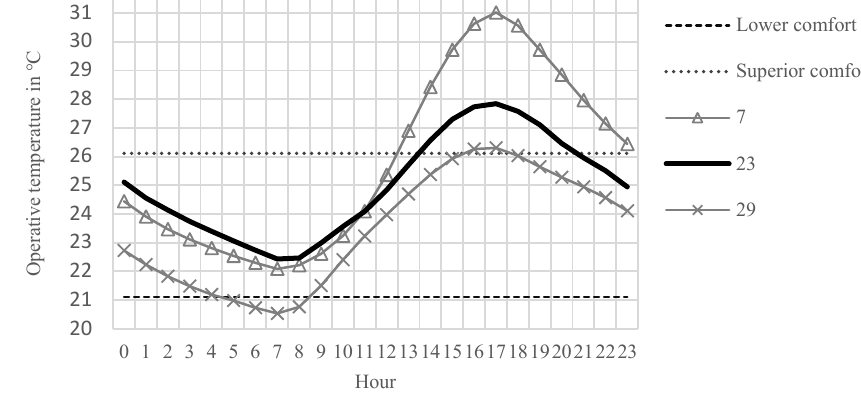
Figure 8. Operative temperature for Season